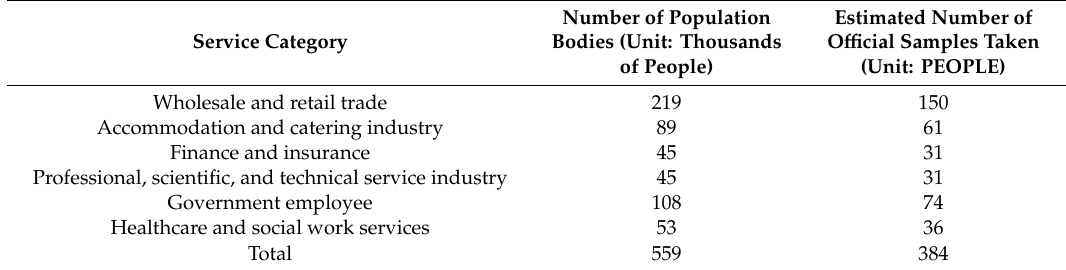
Table 1. Estimated number of urban workers in the second largest city in